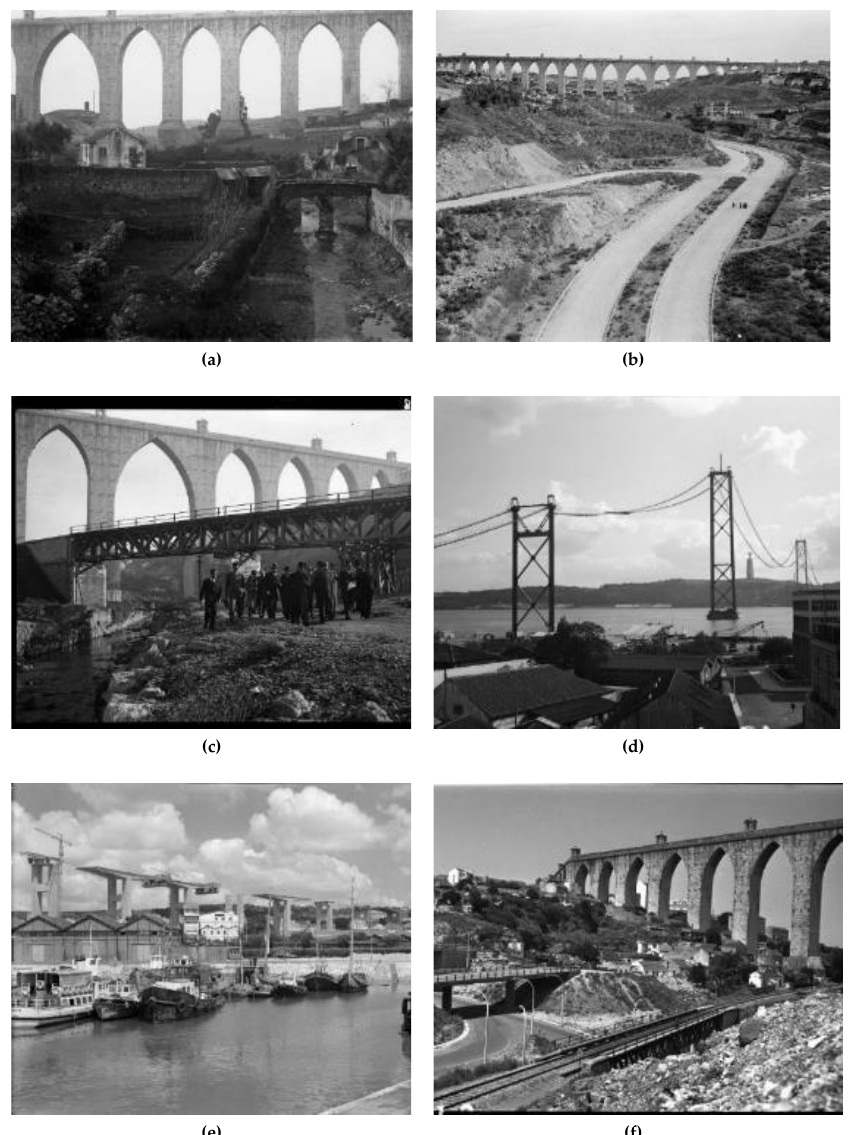
Figure 3. ( a ) Figure 3. Historical Photographs — courtesy of the Lisbon Municipal Archive. (a) Aguas Livres Aqueduct and Rabicha bridge over the Alcântara Stream — Source: [Aqueduto das Á guas Livres e ponte da Rabicha, sobre a Ribeira de Alcântara], [c.1912], Paulo Guedes, photographer, PT/AMLSB/CMLSBAH/PCSP/004/PAG/000396; (b) Á guas Livres Aqueduct over Ceuta avenue —